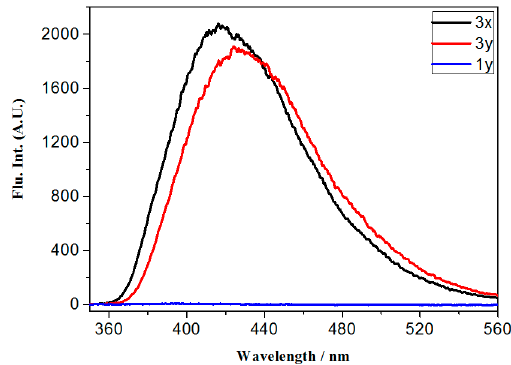
Figure 9. The absorption spectra of compounds 3x , 3y , 1y .